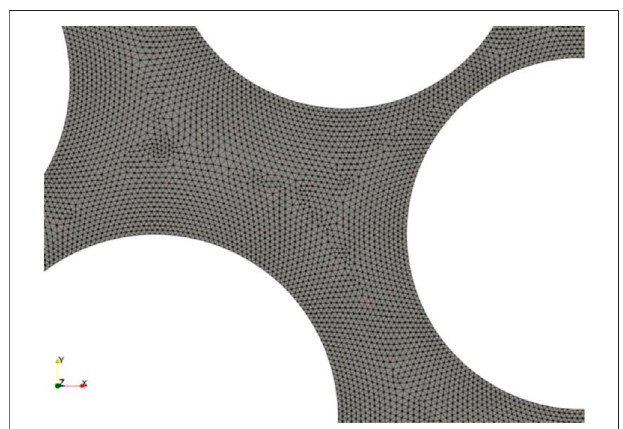
FIGURE 11 | Detailed view of the simulation mesh around fi